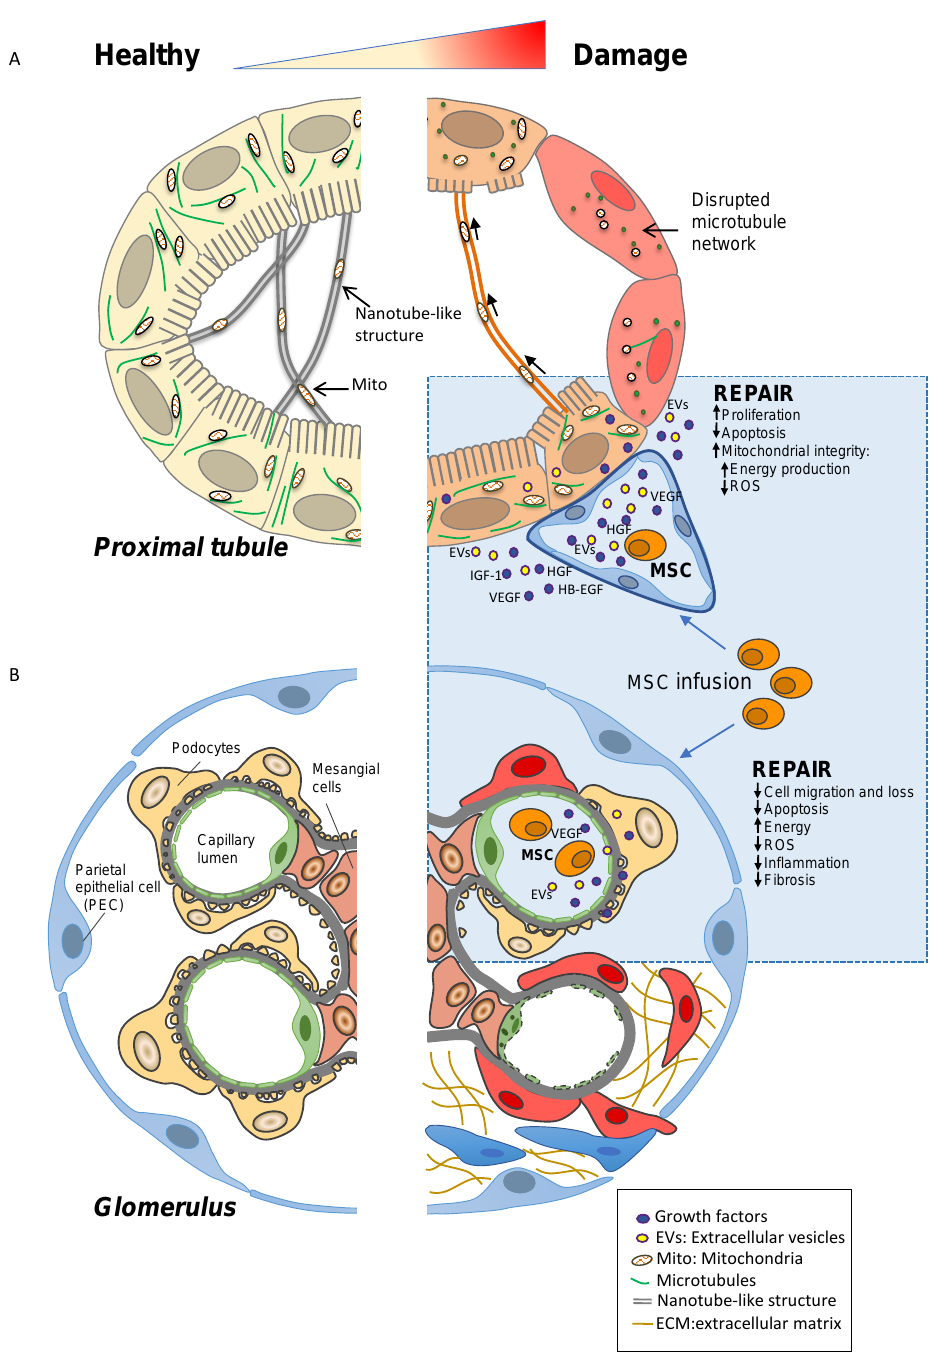
Figure 2. Mechanism of action of MSC-based therapy in kidney diseases. Graphic representation depicting the mechanism of action of MSC-based therapy in ( A ) acute kidney injury and ( B ) chronic kidney disease. ( A ) Following injection, MSCs engraft the damaged kidney and have a protective e ff ect on proximal tubular cells through the local release of growth factors and extracellular vesicles (EVs) with mitogenic, anti-inflammatory and anti-apoptotic e ff ects. Moreover, MSC bioproducts also reduce oxidative stress, sustaining energy supply and mitochondrial exchange among adjacent tubular cells, thus inducing regenerative processes. ( B ) In CKD, upon infusion, MSCs localise in the damaged kidney and limit podocyte migration and loss, glomerular endothelial cell damage and parietal epithelial cell (PEC) activation through the release of growth factors and EVs. MSC therapy by limiting glomerular cell dysfunction also reduces the formation of glomerular fibrotic and sclerotic